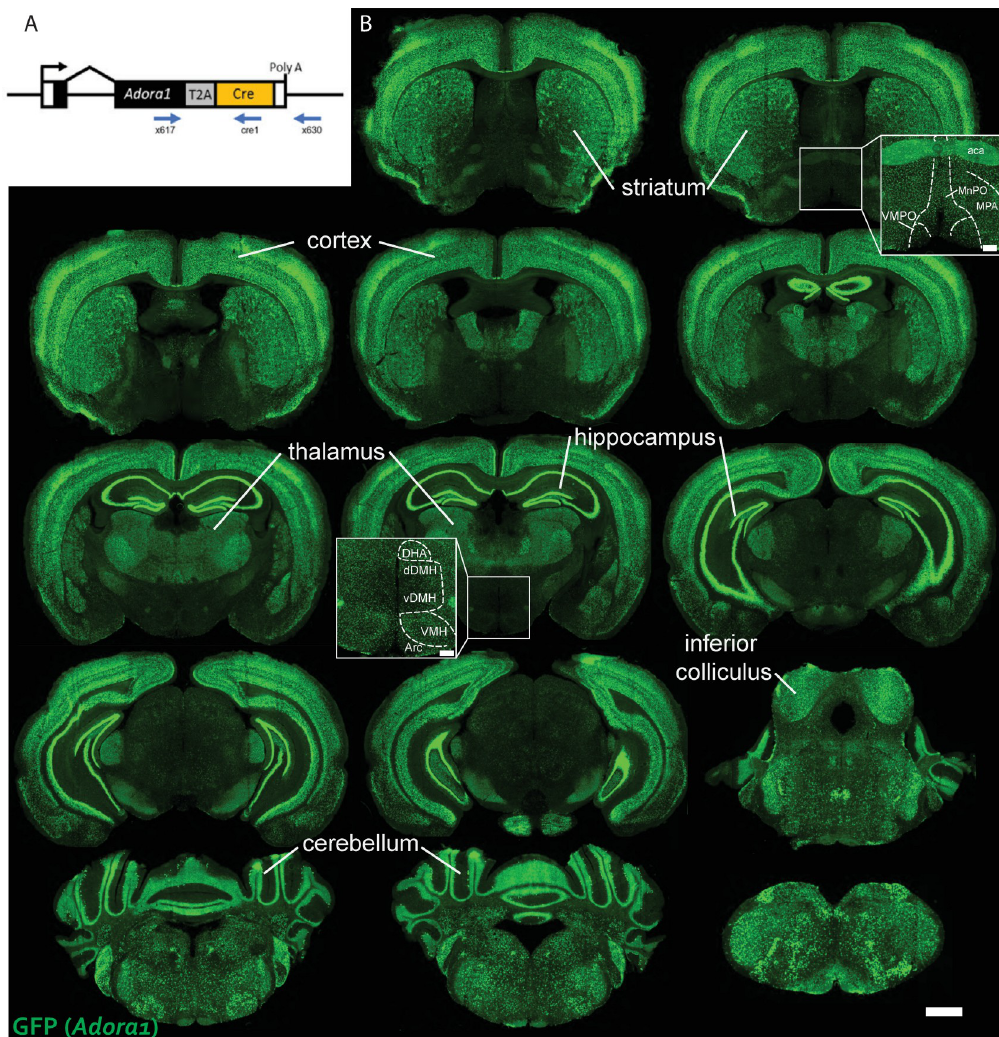
Fig 5. Expression pattern of Adora1-Cre in mouse brain. (A) Schematic representation of the Adora1-Cre allele, showing the Adora1coding region in black, T2A peptide in gray, and Cre recombinase in orange. Primers for PCR-based genotyping are also indicated. Not to scale. (B) Representative brain sections showing Cre-dependent GFP expression in Adora1-Cre;Ai6 mouse brain. Scale bar is 1 mm. Inset scale bar is 200 μ m. MnPO, median preoptic nucleus; MPA, medial preoptic area; VMPO, ventromedial preoptic area; DHA, dorsal hypothalamic area; dDMH, dorsal part of dorsomedial hypothalamus; vDMH, ventral part of dorsomedial hypothalamus; VMH, ventromedial hypothalamus.